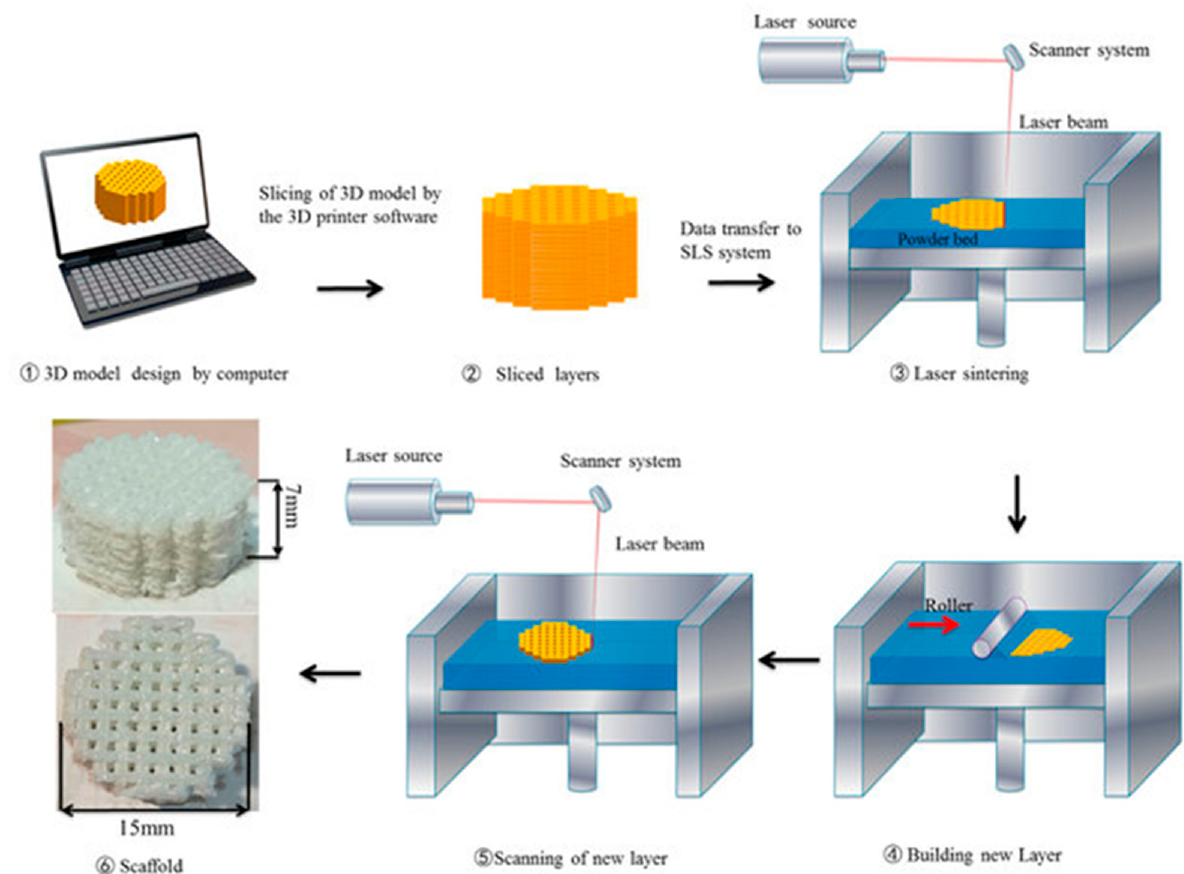
Figure 2. Simplified schematic presentation of the SLS process. Picture taken from an article by Qin et al. [27].